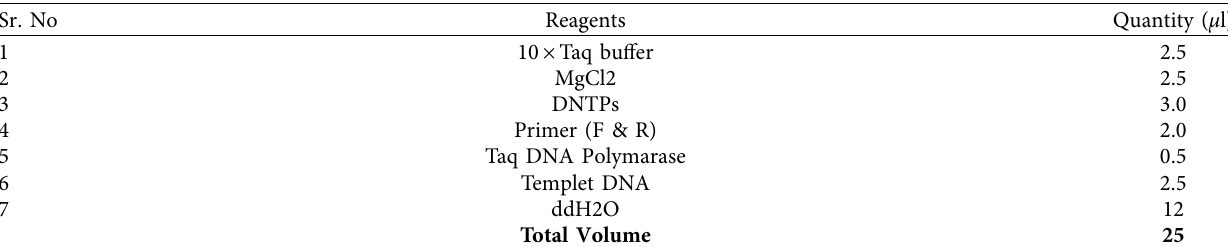
Table 3: Reagents of PCR and their